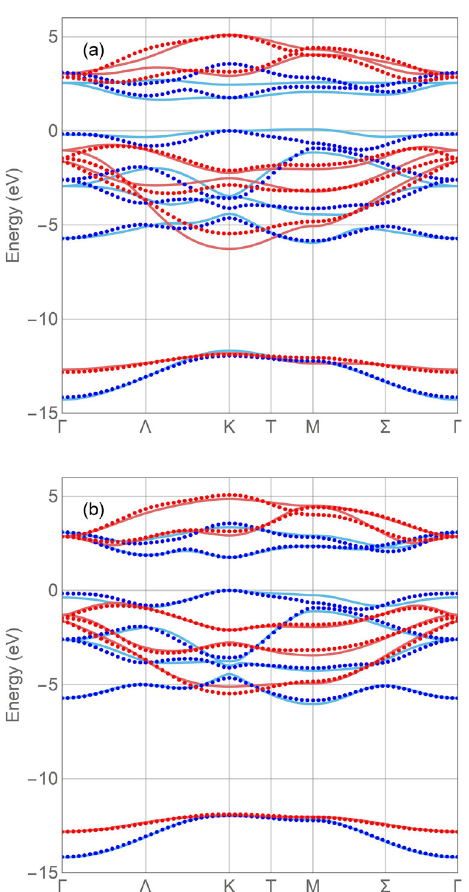
Figure 4. Calculated tight-binding (curves) and DFT (dots) energy bands of the MoS monolayer. Blue (red) curves and dots are for 2 even (odd) Bloch states with respect to the Mo plane. Panel (a) [(b)] is for the computational configuration TBM-20 [TBM-30] which neglects [considers] orbital overlap between neighbor